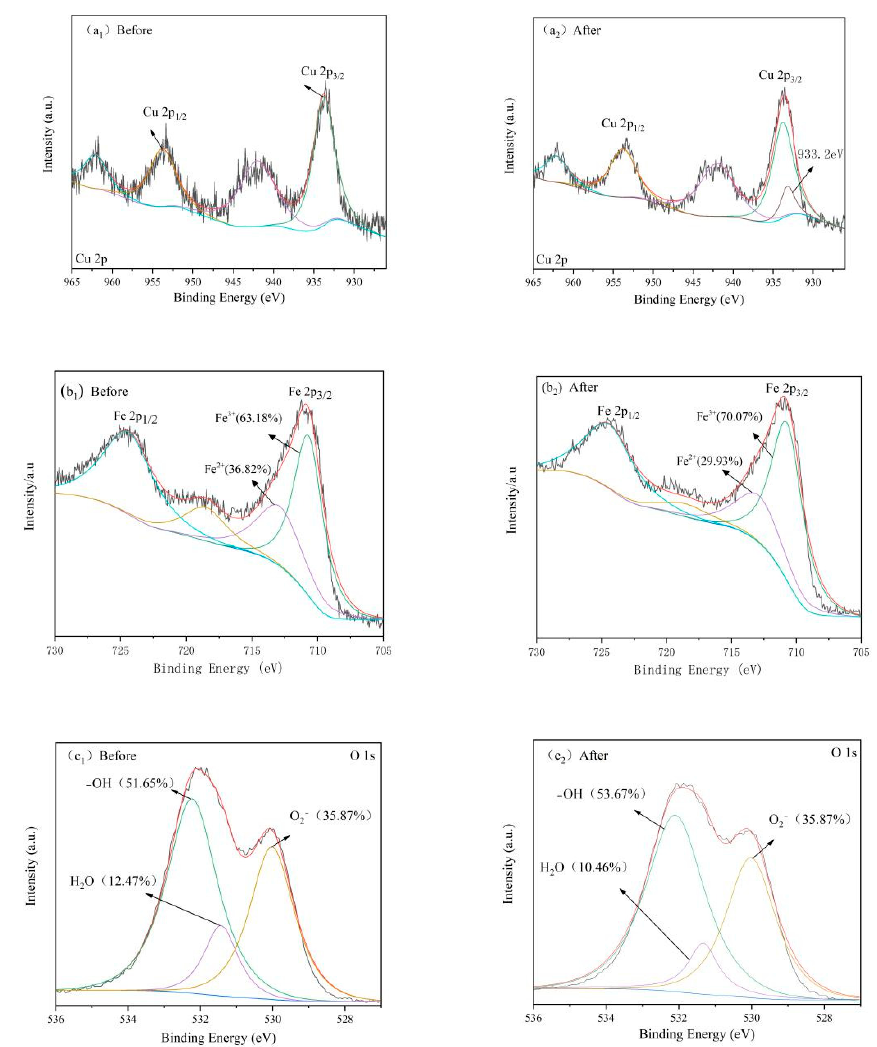
Figure 8. X-ray photoelectron spectroscopy (XPS) of ( a 1 , a 2 ) Cu 2 p , ( b 1 , b 2 ) Fe 2 p , and ( c 1 , c 2 ) O 1 s enveloping Cu 2 Fe 2 O 4 / MMT-k10 (1) before and (2) after use.